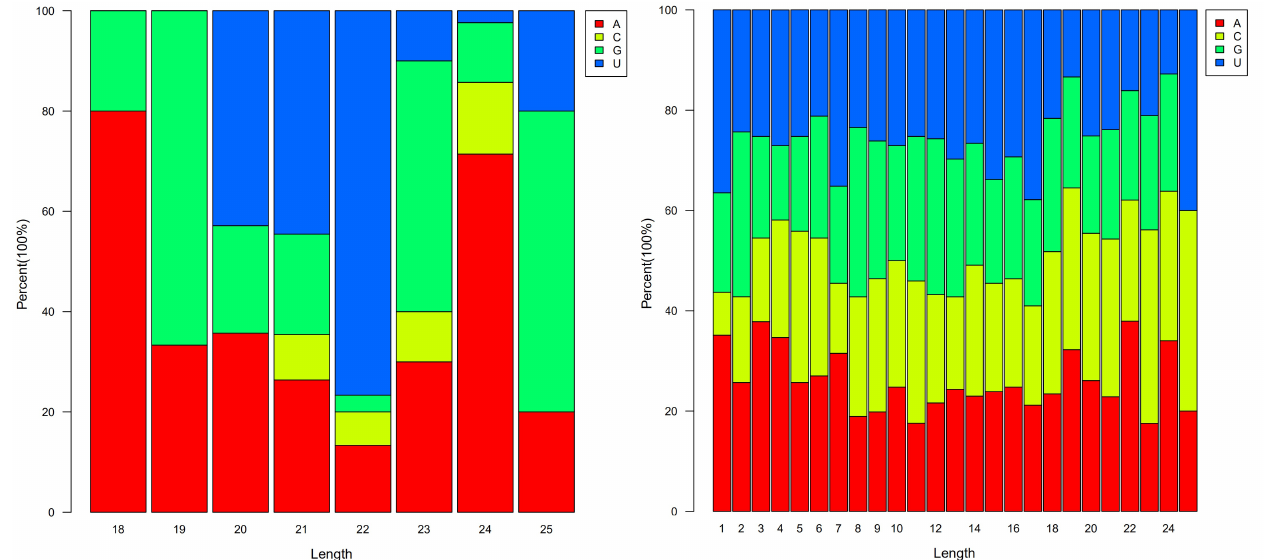
Figure 2. ( a ) First nucleotide, and ( b ) total nucleotide biases of tea oil camellia